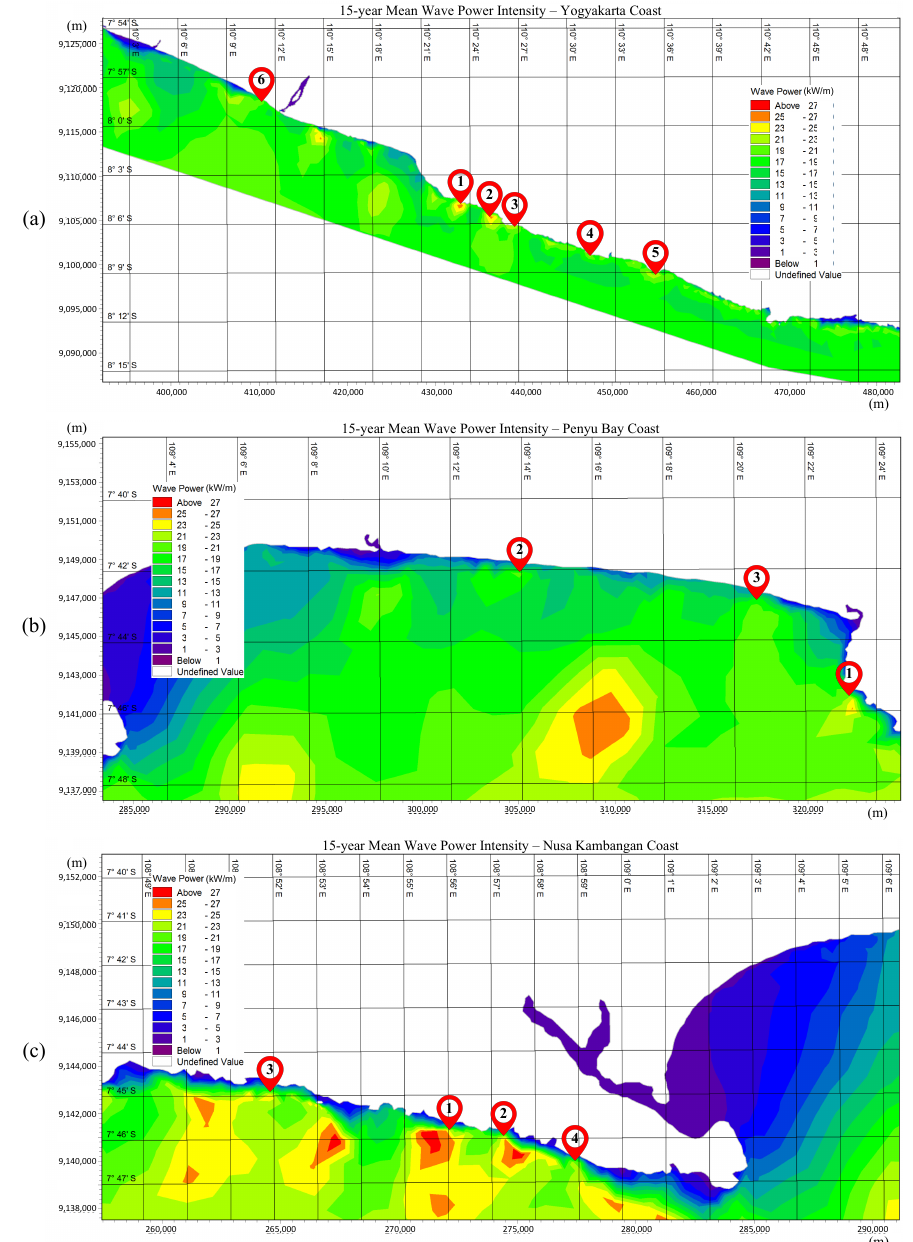
Figure 8. Pin locations of the prospective wave energy converter (WEC) locations in Yogyakarta ( a ), Penyu Bay ( b ), and Nusa Kambangan ( c )